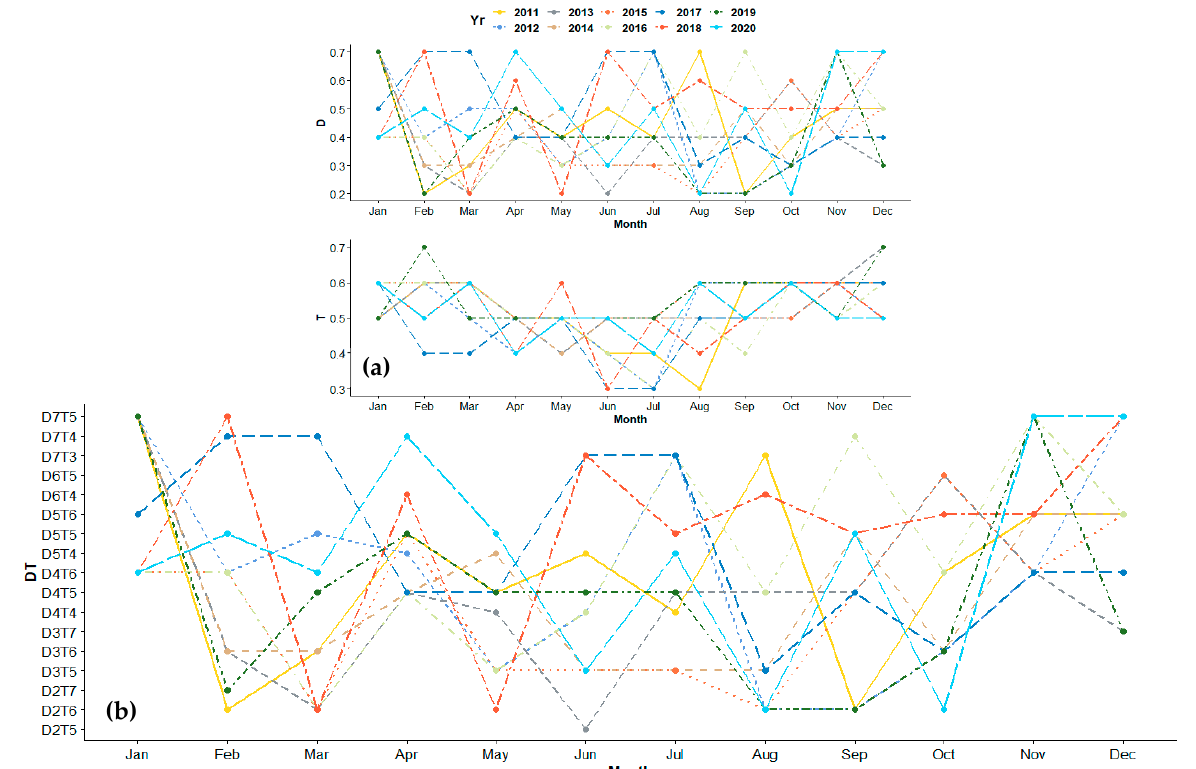
Figure 5. ( a ) Best fit D and T values for monthly calibrations over 10 years. The inverse relationship between D and T values is observed here, ( b ) Calibrated diffusivity (D) and transmissivity (T) combinations for 2011–2020. Although certain combinations are repeated, it is hard to find a pattern with these reoccurring combinations.